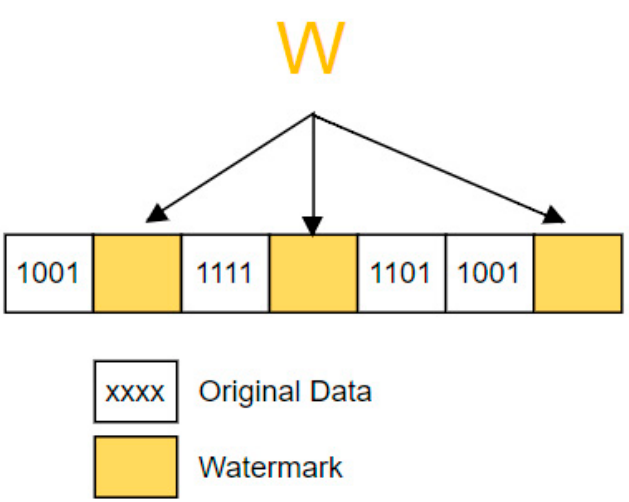
Figure 4. Watermark embedding.